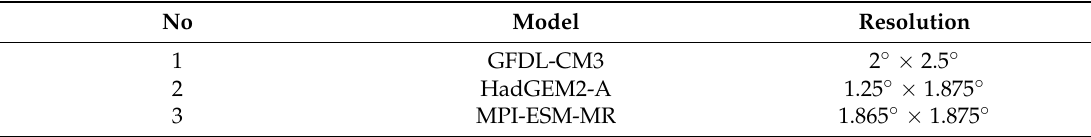
Figure 4. Comparison of Awash basin precipitation observation from CHIRPS with selected three global climate models historical simulations and their ensemble for the period 1981–2005. Table 1. Selected climate models that met the criteria of capturing characteristics of precipitation over the Awash